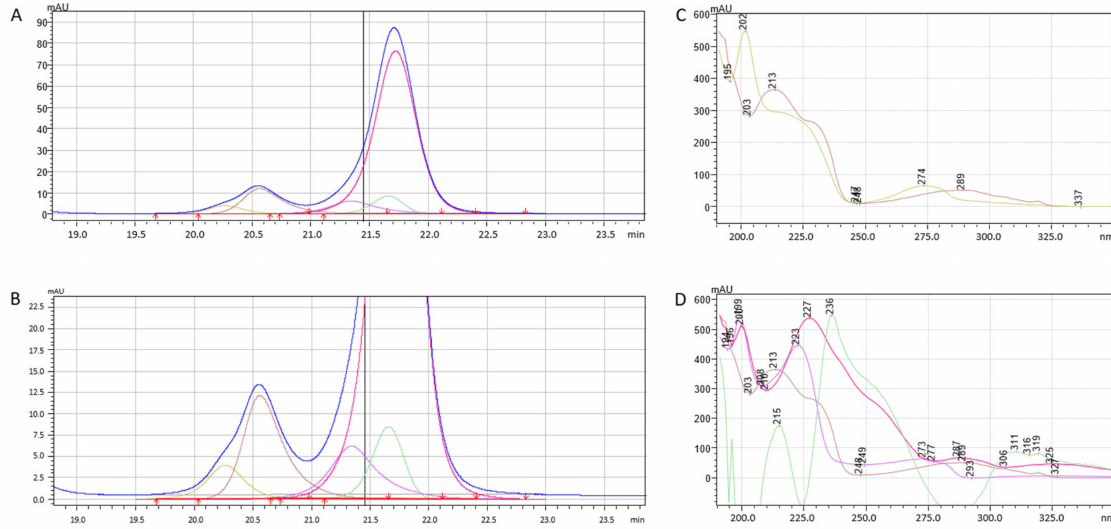
Figure 7. Deconvolution of unseparated compounds ( A , B ) and corresponding UV spectra ( C , D ). Deconvoluted signal of various compounds are plotted in different colors whereas navy-blue line represents the signal from detector.